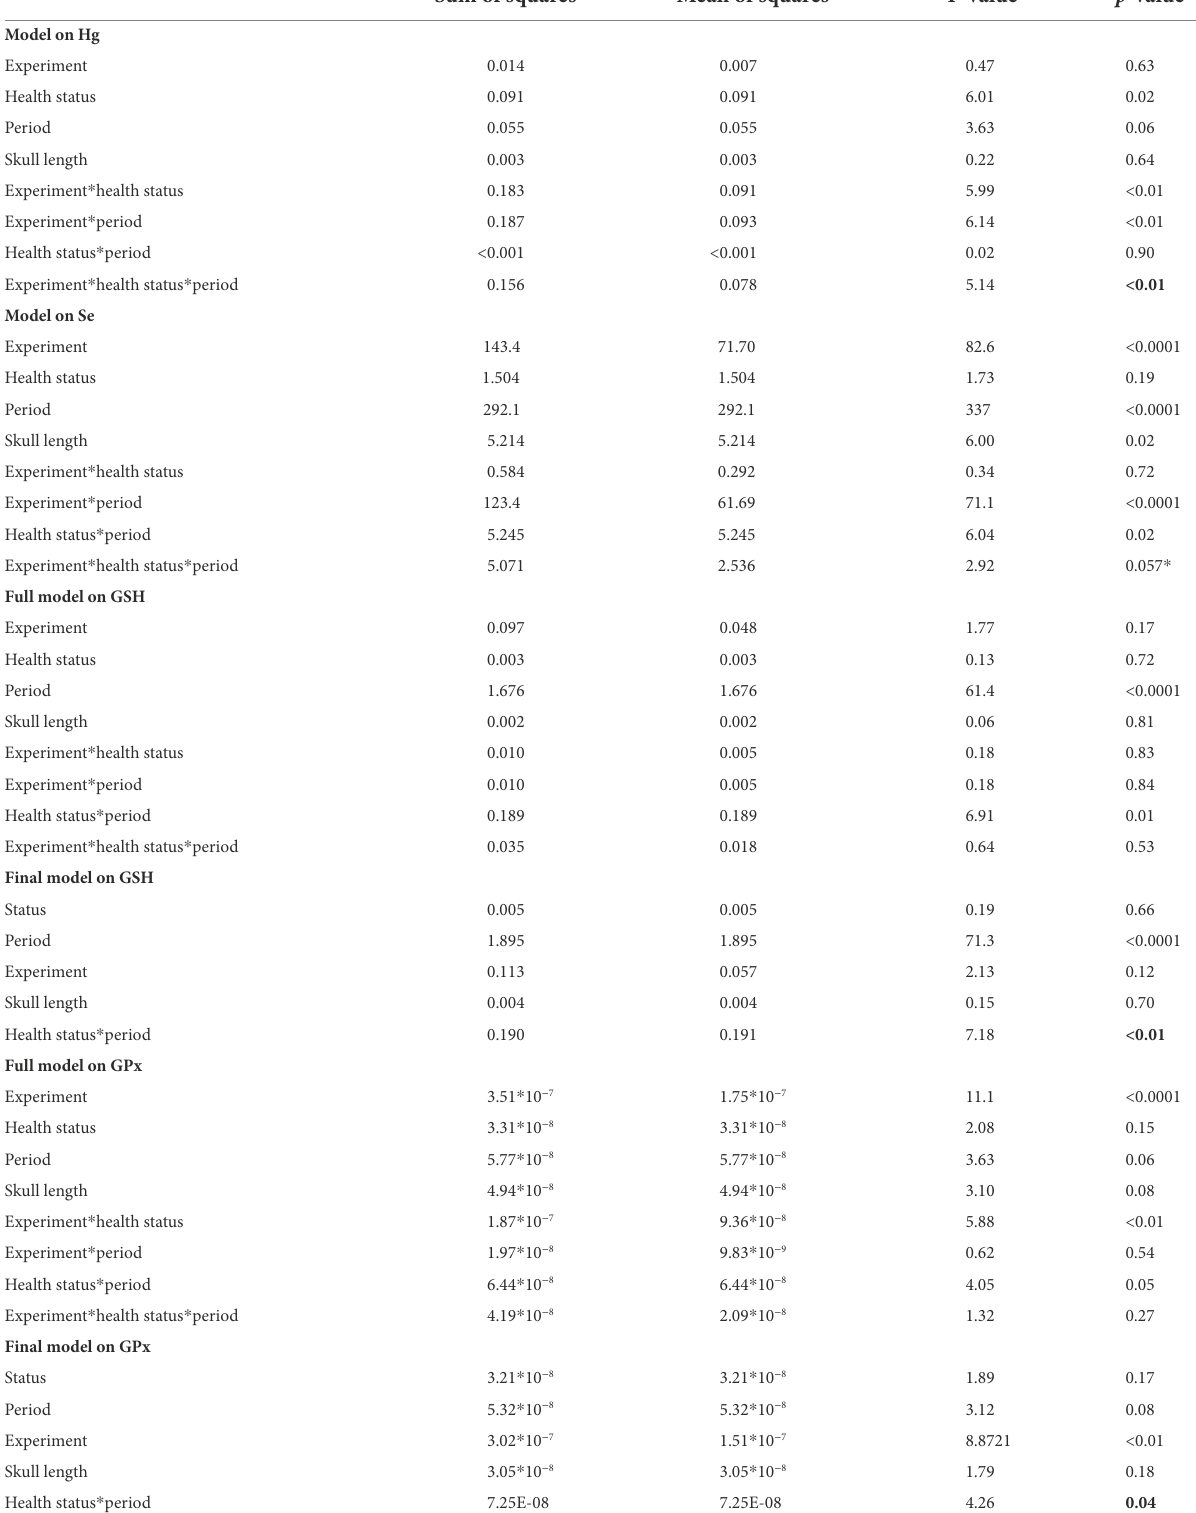
TABLE 1 Linear mixed models among groups divided based on the health status, the treatment received, and the experimental period. Sum of squares Mean of squares F -value p